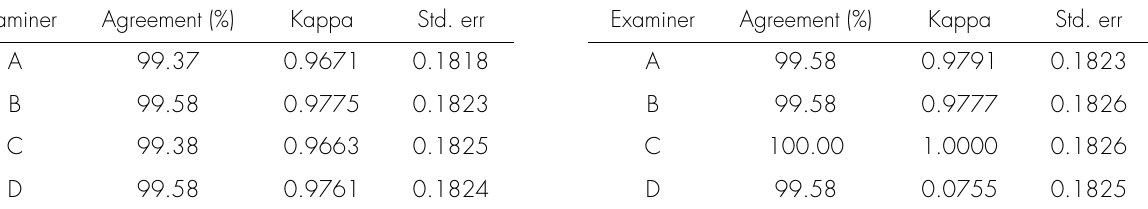
Table II. Intra-examiner agreement and Kappa of the IOTN-DHC for the study models. Examiner